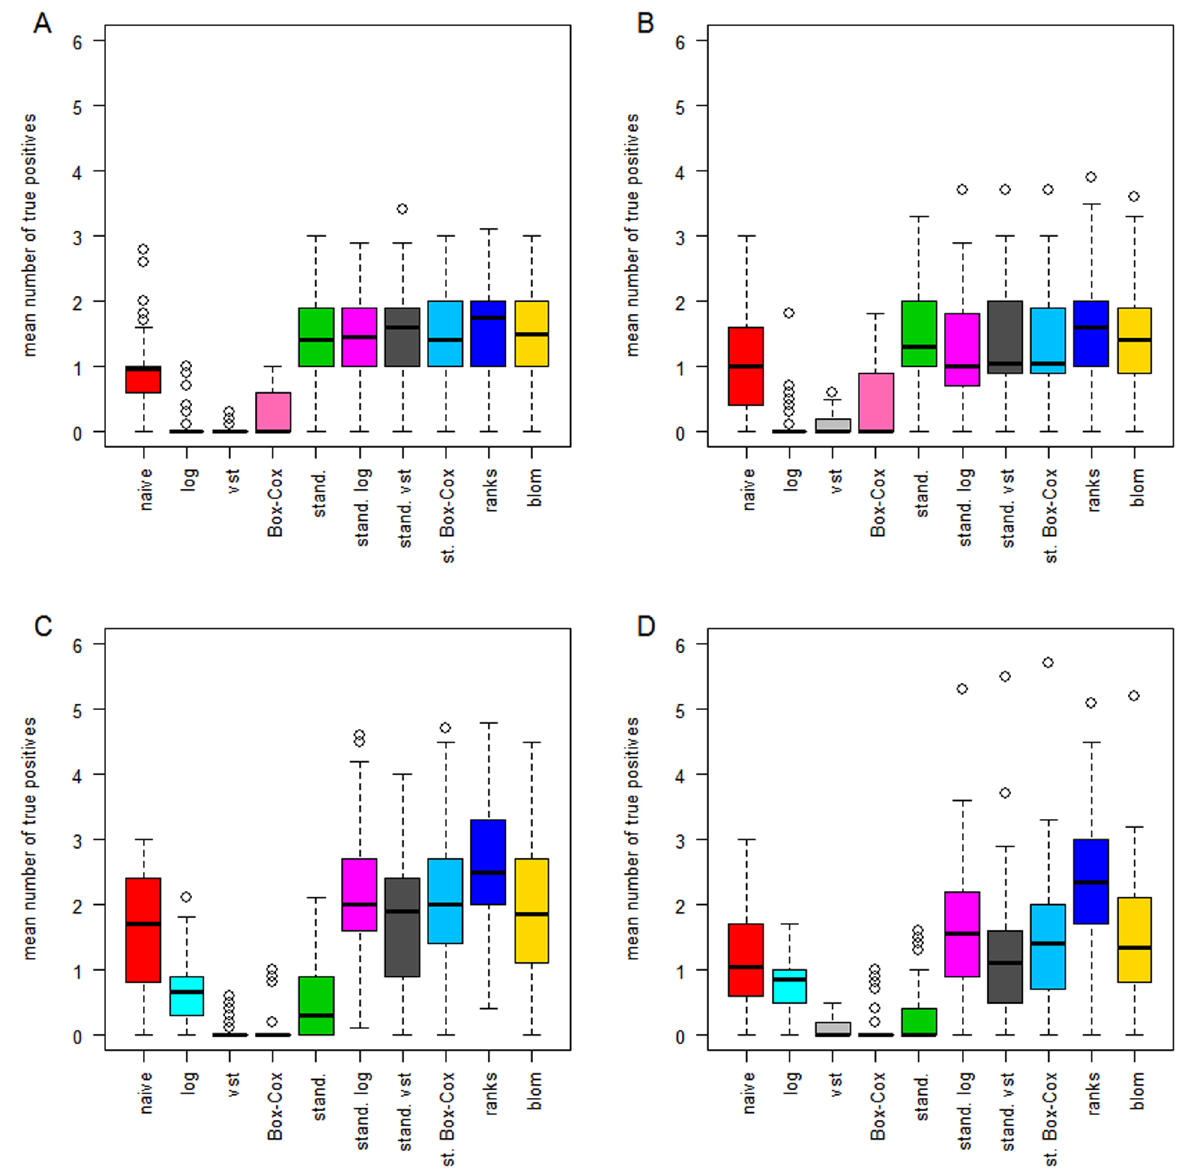
Figure 3. Areas under the curve for the simulation study. A: 10 genes have a linear effect on the patient outcome. B: 20 genes have a linear effect. C: 10 genes have a logarithmic effect. D: 20 genes have a logarithmic